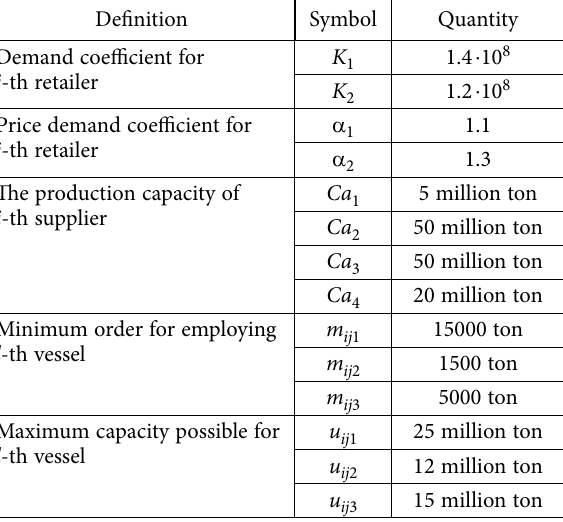
Table 2. Parameters of steel supply network